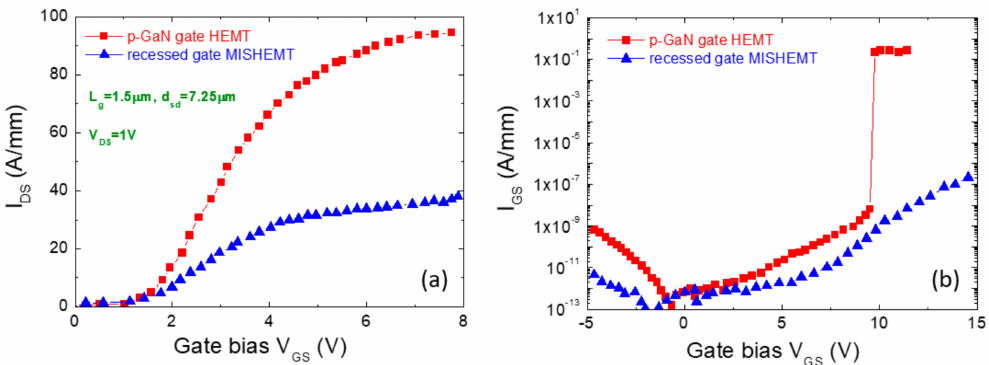
Figure 8. ( a ) Comparison of the transfer characteristics (at V DS = 1 V) of normally-o ff HEMT with p-GaN gate and recessed gate MISHEMT. ( b ) Forward leakage current of the same devices. The figure has been adapted from reference [72] with the permission of the